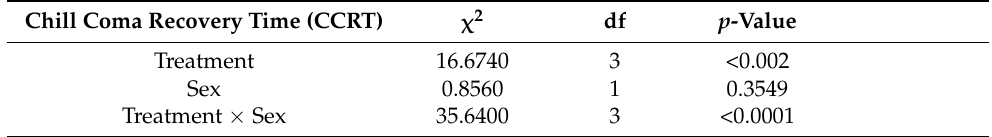
Table 1. Results of the full (saturated) model of the generalized linear model investigating chill coma recovery time, spontaneous behaviour and flight performance following vibration and temperature pre-treatments showing the F-value (flight performance) or Chi-square value ( χ 2 ) (spontaneous behaviour), degrees of freedom, residual degrees of freedom and the p